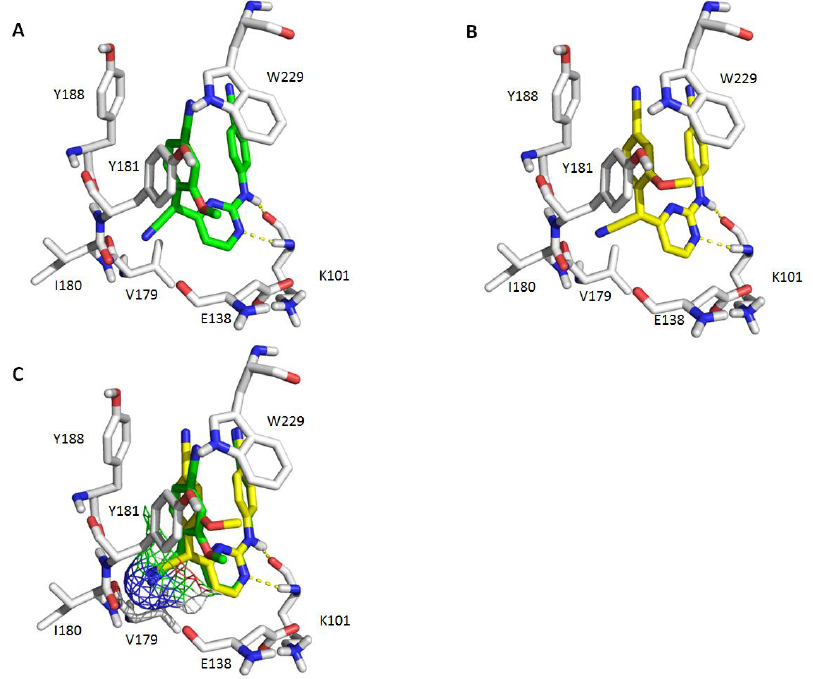
Figure 3. Predicted binding modes of compound A5 with reverse transcriptase (RT) (PDB: 2ZD1). ( A )